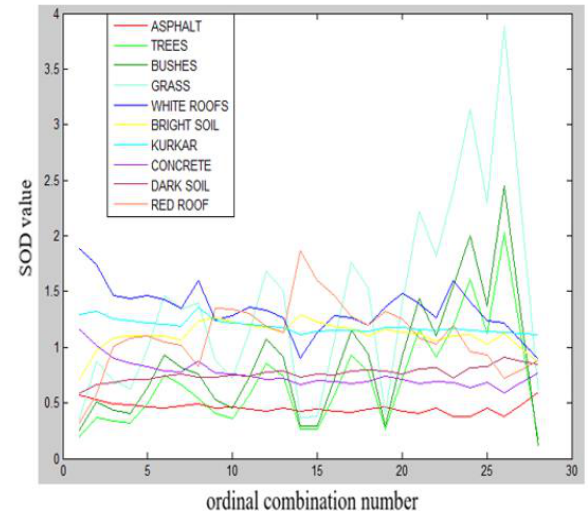
Figure 5. Sum of differences values for each band in slope domain for all land cover’s types.